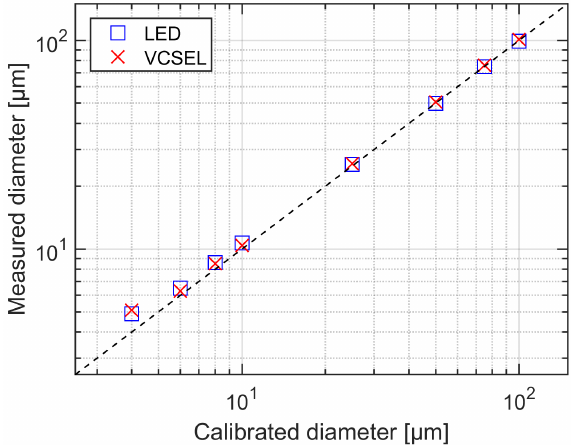
Figure 8. Measured diameter comparisons with calibrated diameter for metal-printed opaque disks of various diameters ranging from 4 to 100 µm. These measurements were performed with the scene illuminated by the LED and VCSEL light sources.